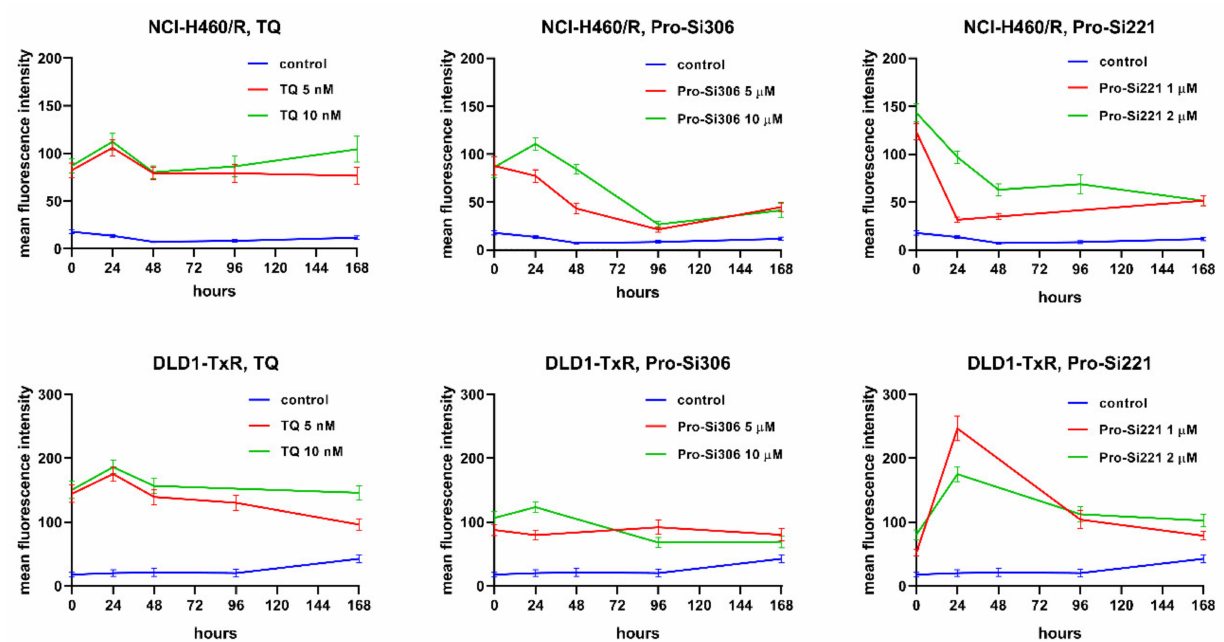
Figure 7. Sustained inhibition of P-gp after acute treatments with pro-Si306 and pro-Si221. Mean fluorescence intensity of Rho 123 accumulation assessed in NCI-H460/R and DLD1-TxR cells treated with pro-Si306 and pro-Si221 for 24 h, 48 h, 96 h, and 168 h. TQ was used as a reference compound. Three independent experiments were performed (a minimum of 10,000 events were collected for each experimental sample).